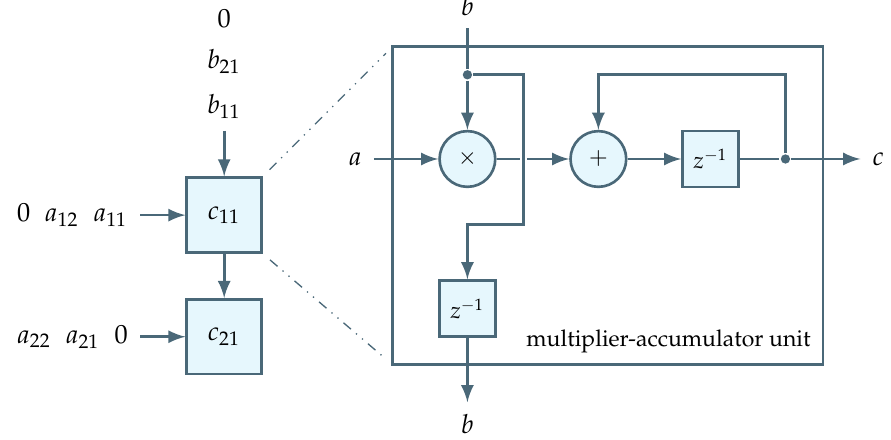
1 vector b by a 2 2 matrix A × ×